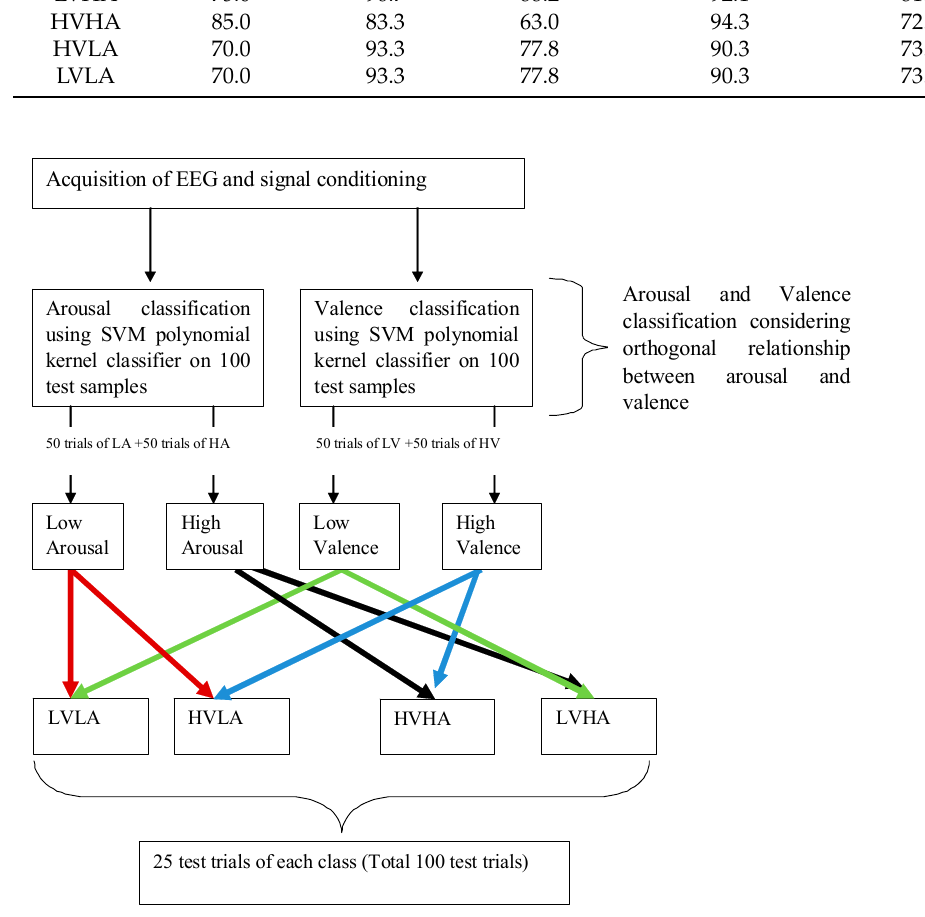
Figure 7. A two ‐ classifier methodology used. Figure 7. A two-classifier methodology